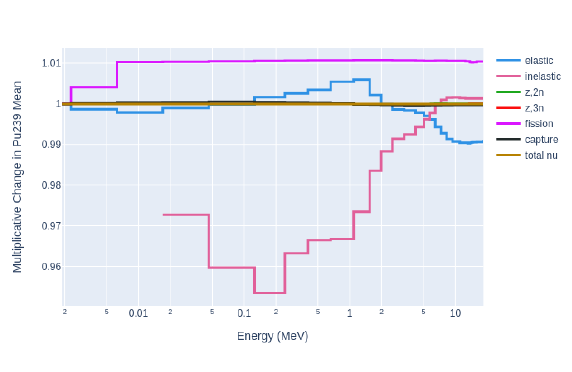
Figure 7. The same as the top-plot of Fig. 5 except for adjust- ment to fission reaction rates in the Jezebel critical